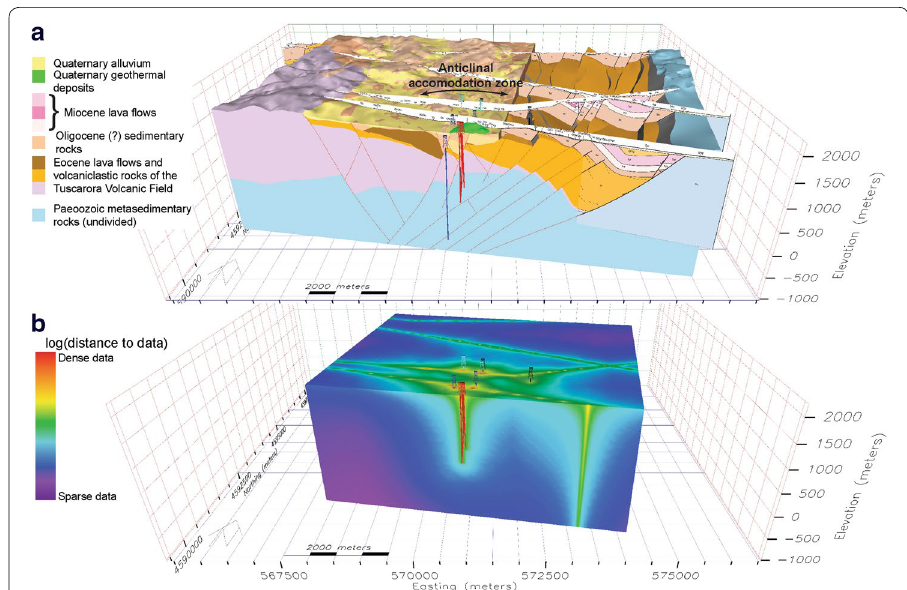
Fig. 7 a 3D geologic map, selected cross sections (Dering 2013) and well data from the Tuscarora geothermal field. View direction is to the north. Fluid upwelling is interpreted to be controlled by intersecting oppositely dipping faults in the axial part of an anticlinal accommodation zone. Geothermal production wells (red) and injection wells (dark blue are the proximal, light blue are the distal injection wells) are shown for reference. The black wells are other deep wells with lithologic data. Black arrow marks the anticlinal accommodation zone where fluid upwelling is focused. Cross section shown is through the geothermal field, sliced along azimuth 105. b 3D model of logarithm of distance to data at Tuscarora, sliced at the same latitude as a . There are dense data (several wells and a cross section) in the heart of the geothermal field suggesting that the 3D geologic relationships in the near surface (where the surficial geology is mapped in detail) in this area are well constrained relative to areas of more sparse